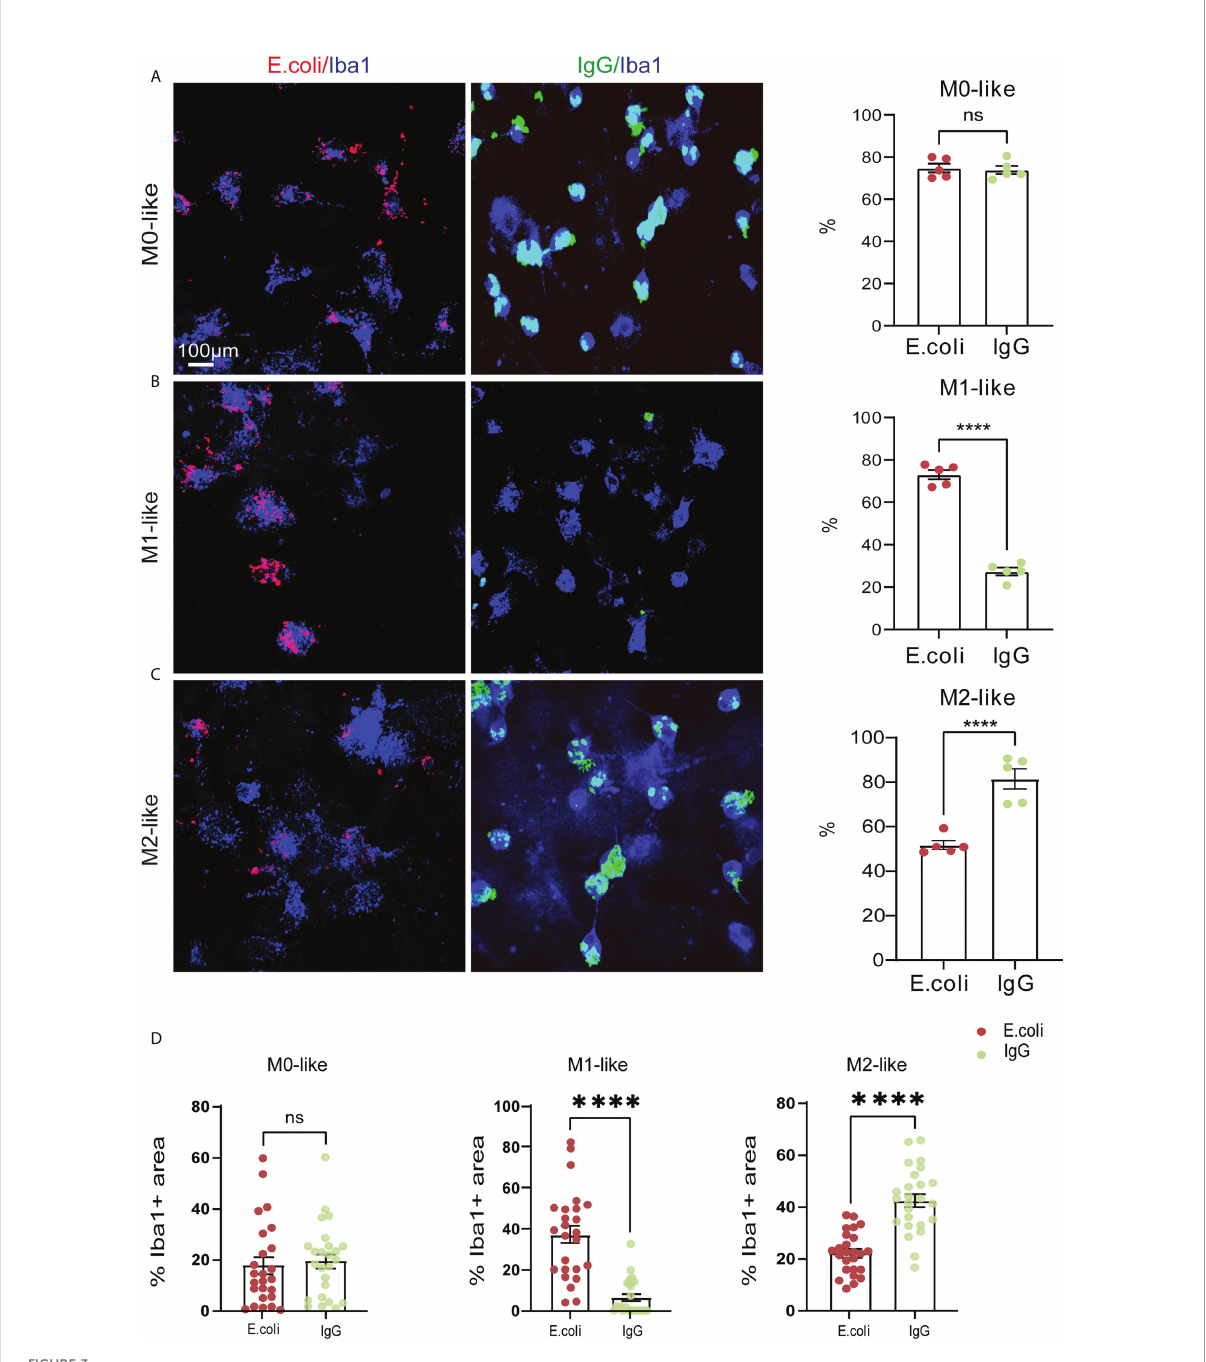
FIGURE 3 M1- and M2-like microglia show substrate-speci fi c phagocytosis preference and capacities. (A – C) Confocal images showing anti-Iba1 immunostaining of M0-, M1- or M2-like microglia subtypes along with rhodamine-E.coli particles (red, E.coli) or IgG-FITC beads (green, IgG) after 3 hours of phagocytosis substrate exposure. Histograms showing percentage of microglia with internalized E.coli particles or IgG beads. M0-like microglia showed no phagocytosis preference, whereas M1- and M2-like microglia showed opposing phagocytosis preferences for E.coli particles or IgG beads, respectively. (D) Co-localization analyses showing the relative occupancy of Iba1 immunostained cell areas by E.coli particles or IgG beads. M1- and M2-like microglia displayed opposing phagocytosis capacities for E.coli particles or IgG beads, respectively. Data are expressed as mean ± SEM from 5 independent biological replicates (A – C) or 5 cells from each of 5 independent biological replicate (D) . Data are means ± SEM. ****p < 0.0001, ns, not signi fi cant, Student ’ s